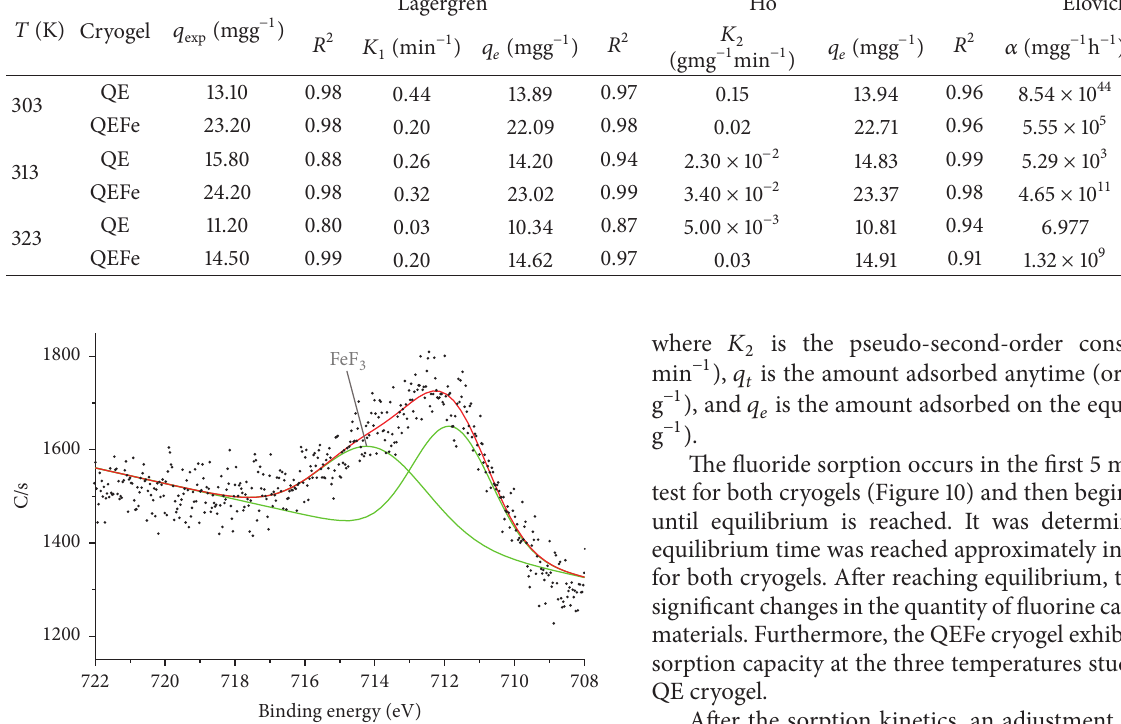
Figure 7: XPS spectrum to Fe2p of QEFe/F −